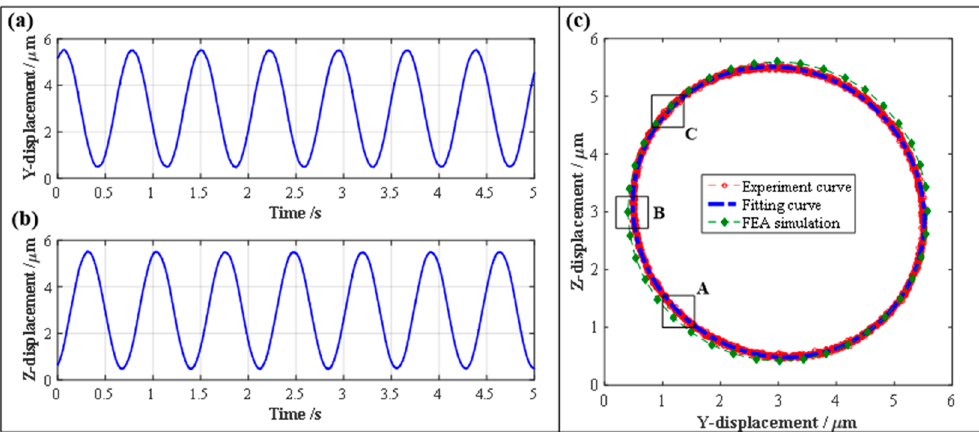
Figure 11. The experimental results of kinematic performance of the 2-DOF PDCM system. ( a ) Displacement in Y-axis, ( b ) Displacement in Z-axis, ( c ) Elliptical trajectory. Figure 11.